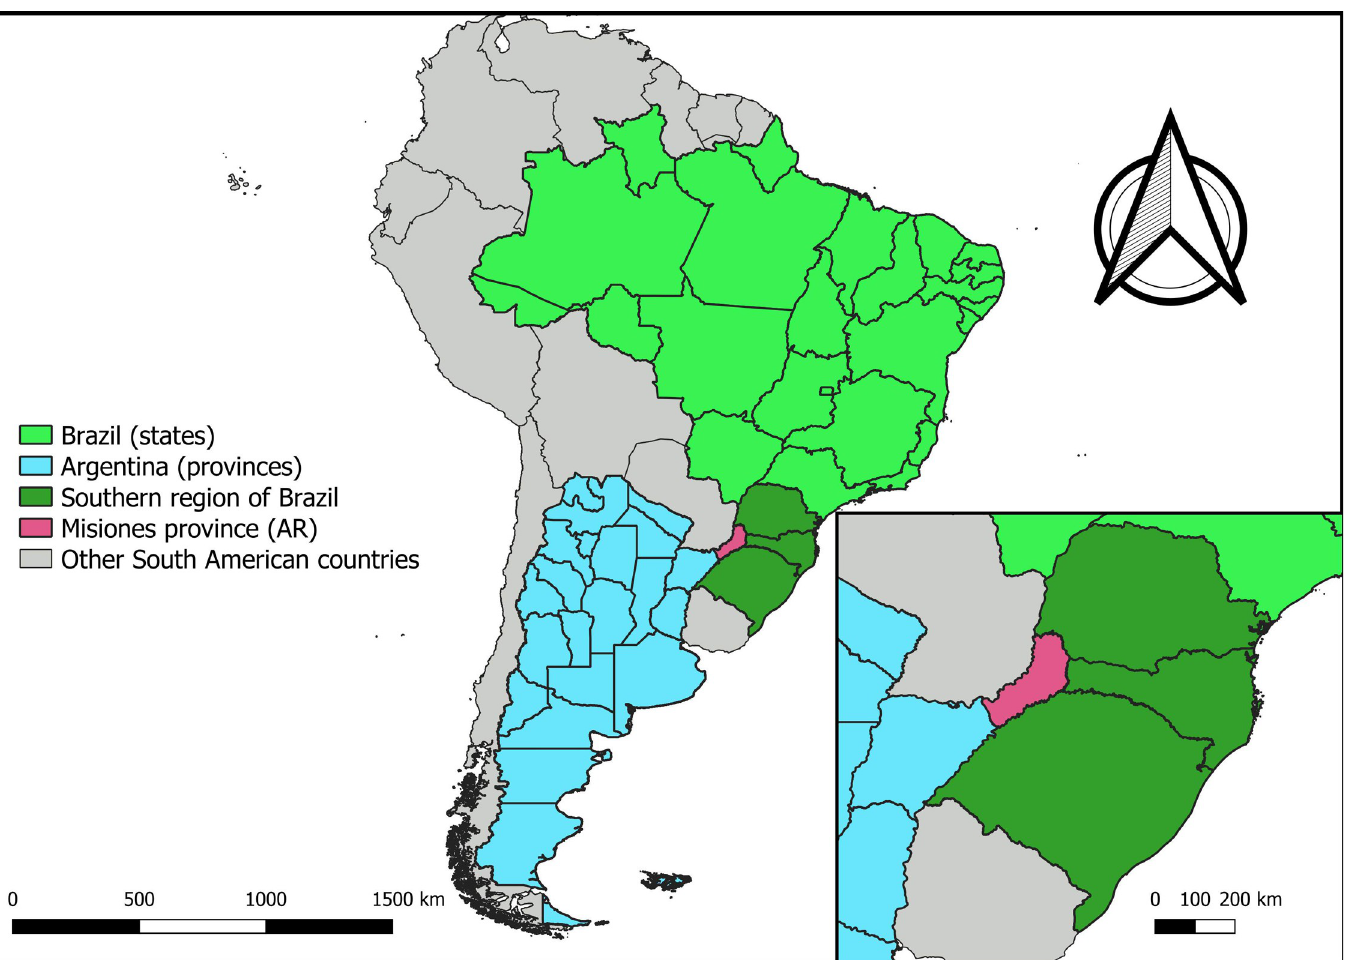
Fig 1. Geographic location of the southern region of Brazil and Misiones province, Argentina, 2019. Source: Oliveira, et al., 2019 [7].